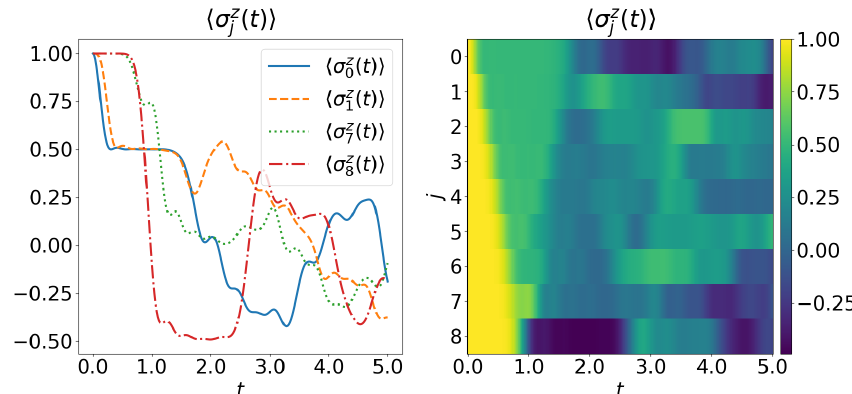
Figure 2: The Pauli Z expectation values vs. time for nine qubits in a 1D chain as in Fig. 1, shown for the two qubits at each edge of the chain (left panel), and using a space-time diagram for all qubits (right panel). Qubit 0 is being driven according to Eq. (20), with the dynamics solved and presented in the rotating frame of Eq. (23). The parameters of Eqs. (24)-(25) are given in Eqs. (26)-(27). The color bar on the right associates the scale of colors to the expectation value of each qubit, plotted in rows from j = 0 to j = 8, for the time varying from t = 0 to t = 5. The propagation of the information signal from the driven qubit manifests as a light-cone in 〈 Z 〉 – see the text for a detailed discussion.